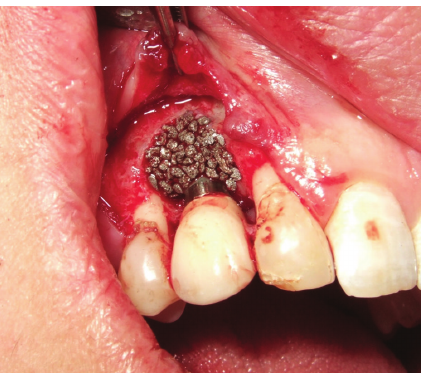
Figure 4: Clinical example of PTG implanted in bone defect around implant in position of upper right canine of patient number